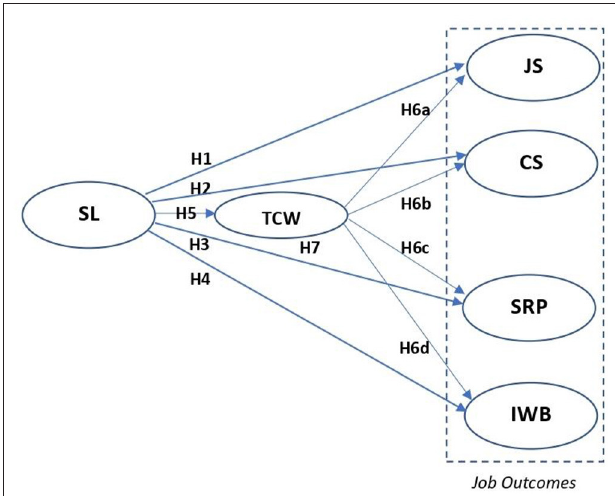
FIGURE 1 | Theoretical